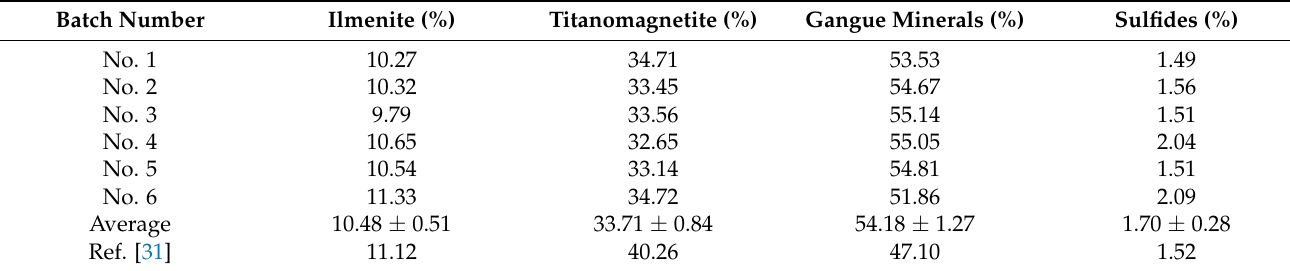
Table 3. Mineral contents of the different ore